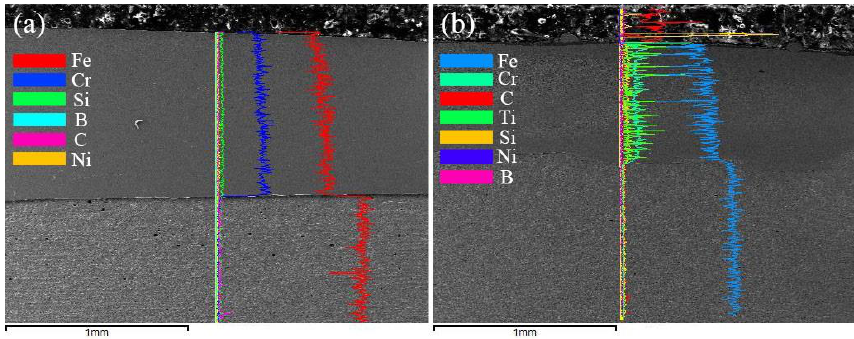
Figure 4. Linear elemental distributions of ( a ) Coating 1 and ( b ) Coating 2.